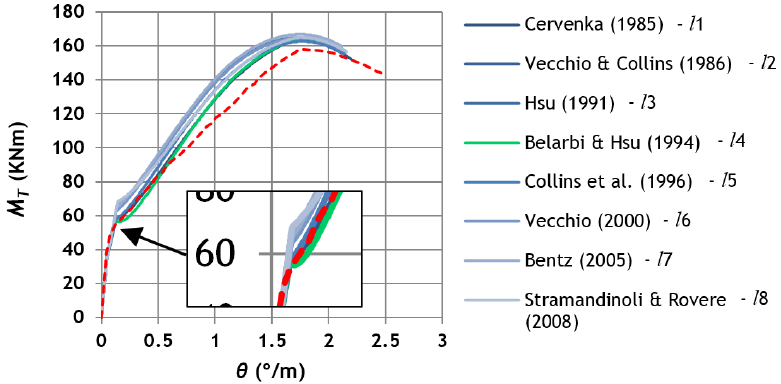
M – θ curves for reference beam N-20-20. Figure 7. Example of M T — θ curves for reference beam T